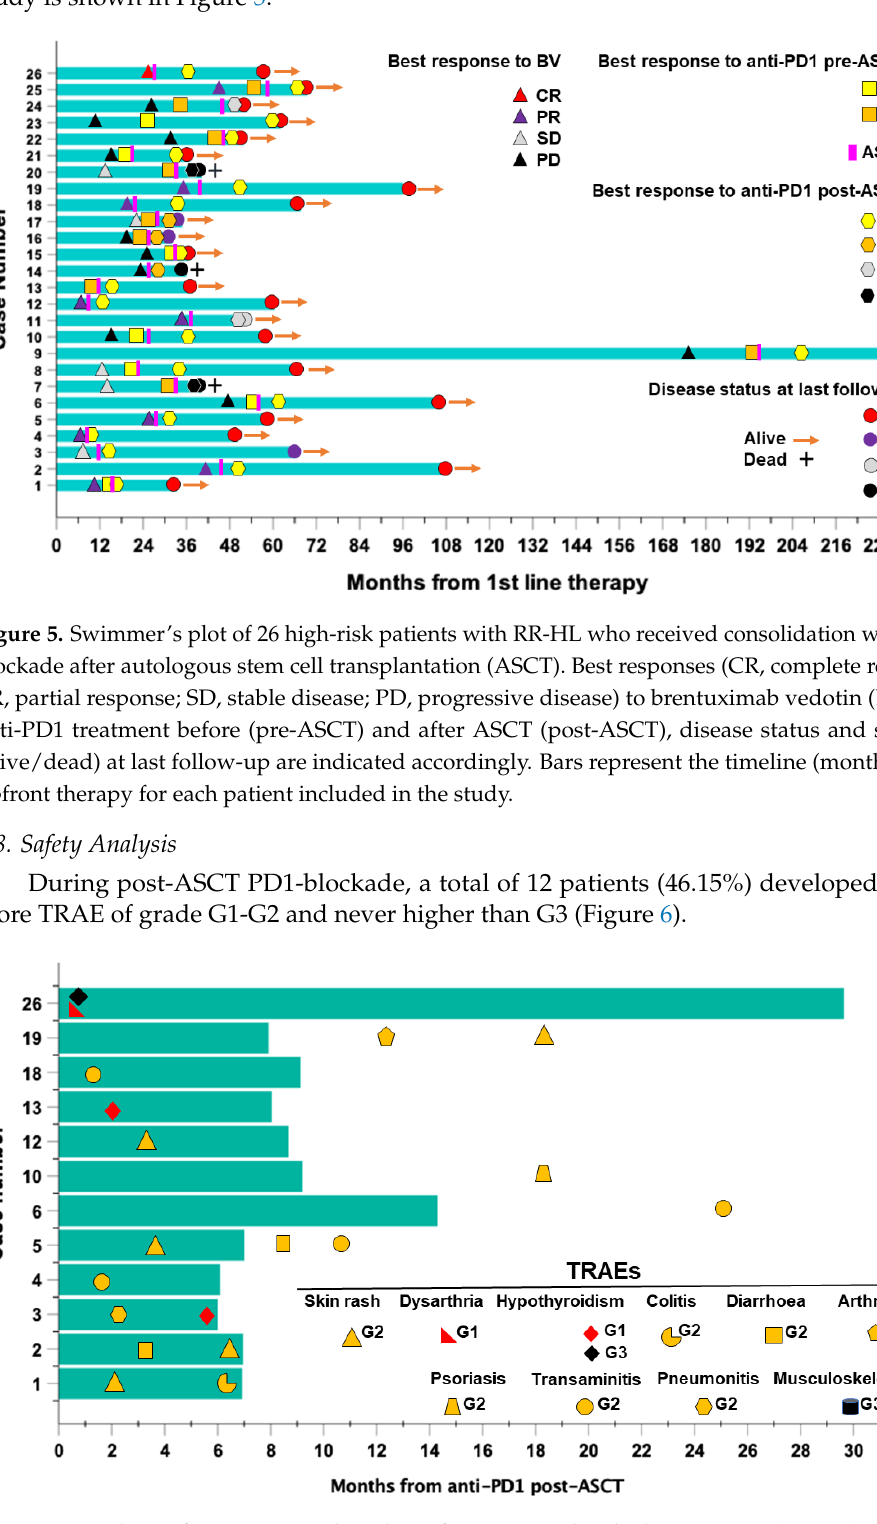
Figure 4. Overall survival (OS), calculated from the day of stem cell reinfusion, for the entire cohort of 26 high-risk patients with RR-HL who received consolidation with PD1-blockade after autolo- gous stem cell transplantation (ASCT).